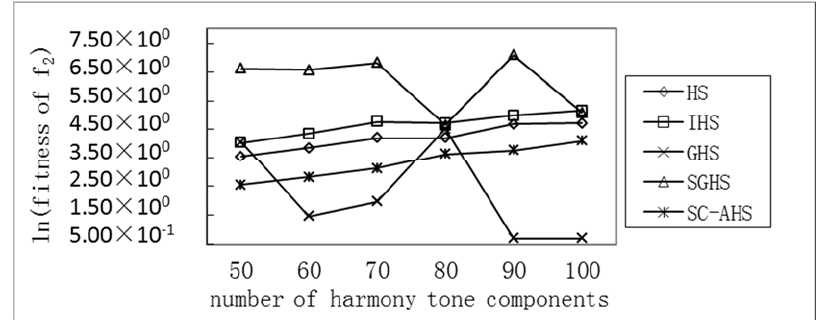
Figure 3. Comparison of the average optimum with different harmony tone components of the Rastrigrin function.